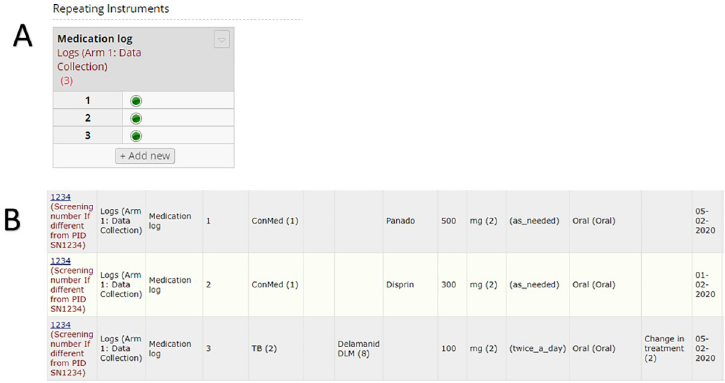
Fig 3. A. Example of repeating instruments for capturing medication data. B. Example of structured report for medication log, showing dummy data.